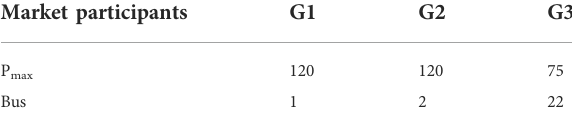
TABLE A2 Parameter settings of thermal units.